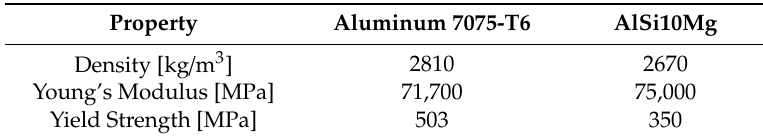
Table 1. Material properties: comparison of Aluminum 7075-T6 for the three-axis milling machine and AlSi10Mg for L-PBF